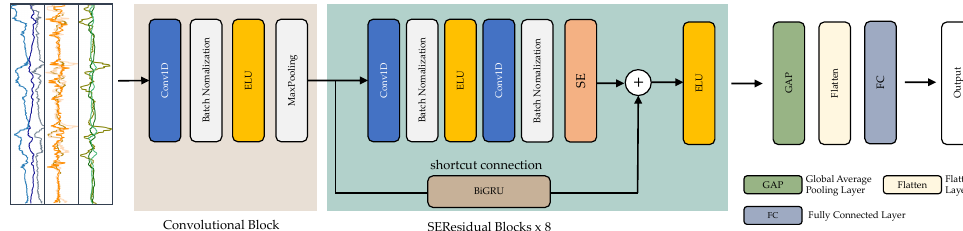
Figure 5. Detailed and unrolled architecture of the proposed SEResNet-BiGRU